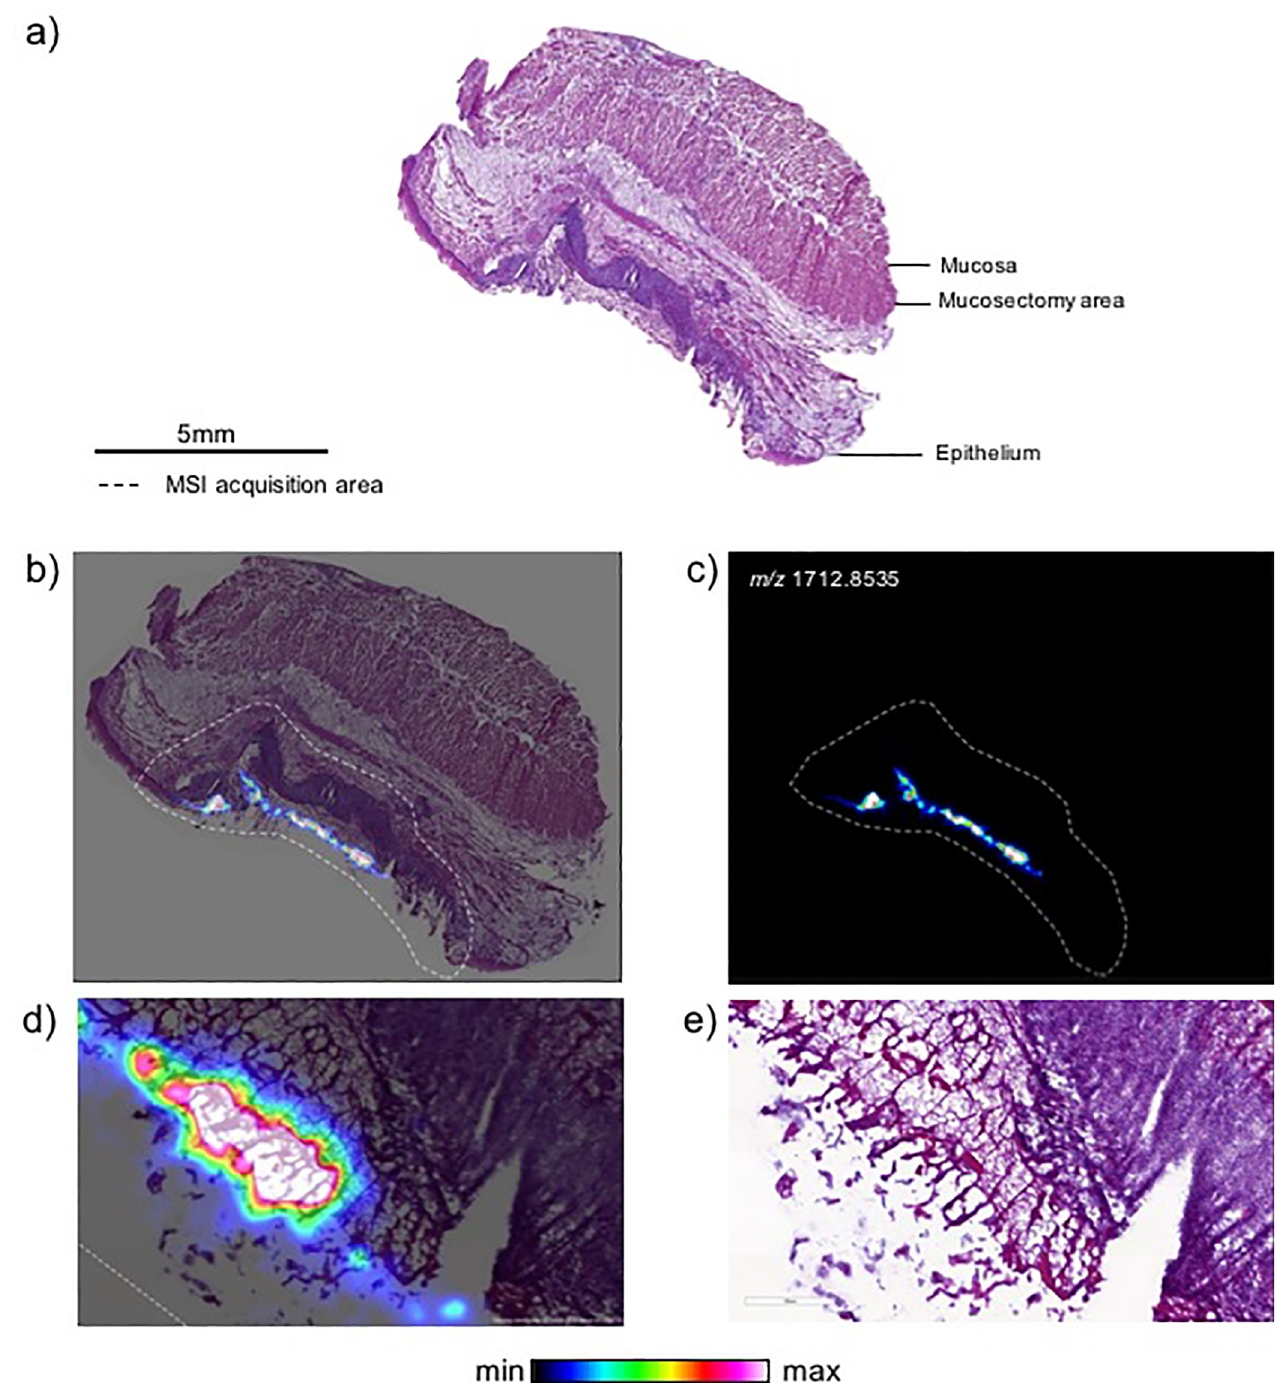
Fig 1. Distribution of PuraStat with MALDI spectrometry imaging in treated pig esophagus section at day 1. a) Hematoxylin & Eosin (HE) staining of a serial section; b) Overlay of the PuraStat distribution and the HE staining, c) PuraStat molecular distribution only; d) Zoom in the overlay; e) Zoom in the HE staining